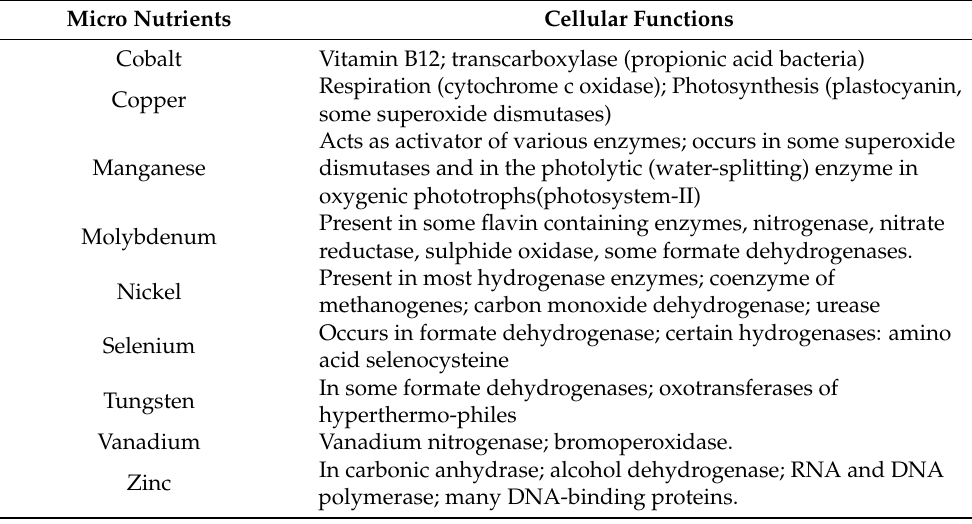
Table 4. Micro-nutrients for cell growth and their cellular